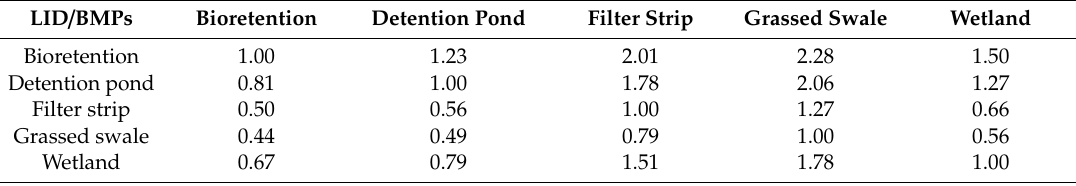
Figure 6. The identified critical hot spots (CHSs) using the LPSAI method. Table 7. Pairwise comparison matrix based on sediment reduction at sub-watershed 78 using the CII method.